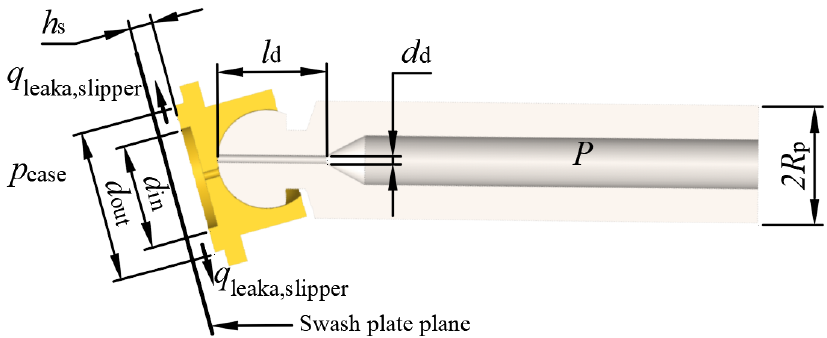
Figure 5. Schematic diagram of leakage flow of slipper/swash plate interface.